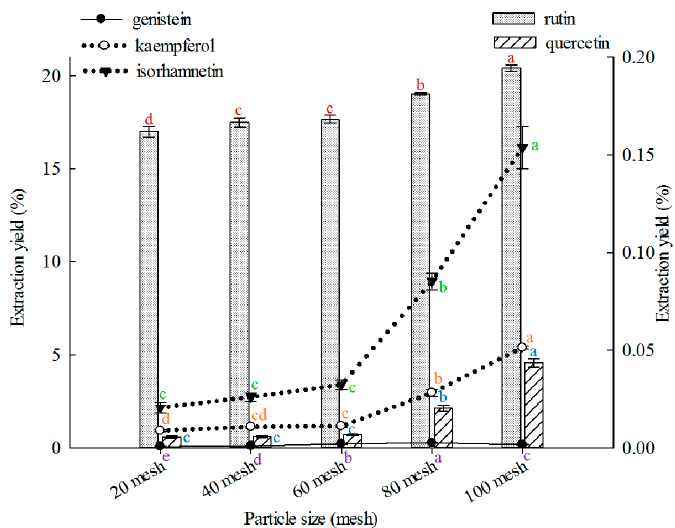
Figure 2. Effects of particle size on the extraction yields of the five constituents (the bar and lines graphs are referenced to the left and right axes, respectively; different letters stand for significant difference at 5% level).